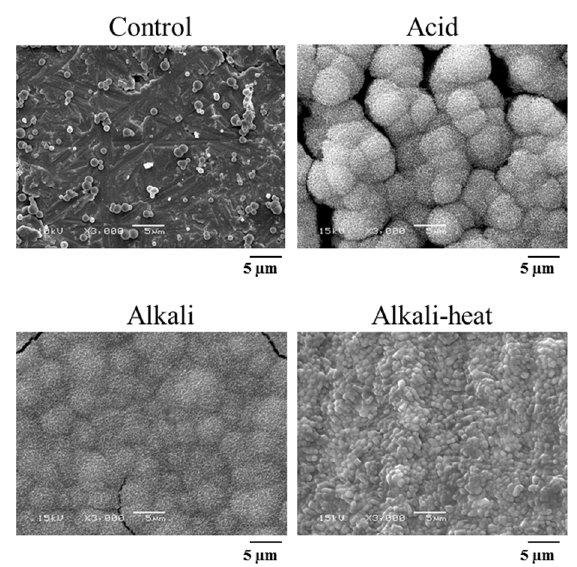
Figure 7. SEM pictures of the surface appearances of Ti disks after 1 day of HBSS immersion.